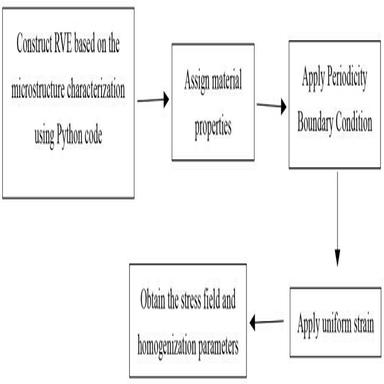
A flowchart for the homogenization approach applied in this work.